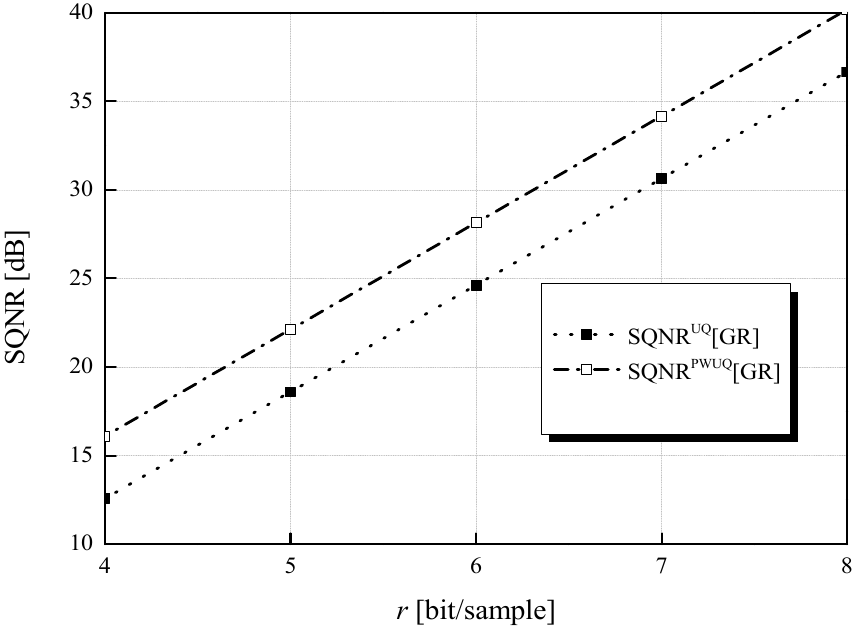
Figure 3. Constant SQNR gain of 3.523 dB that is achieved by PWUQ over UQ in GR case for r ranging from 4 bit/sample to 8 bit/sample.